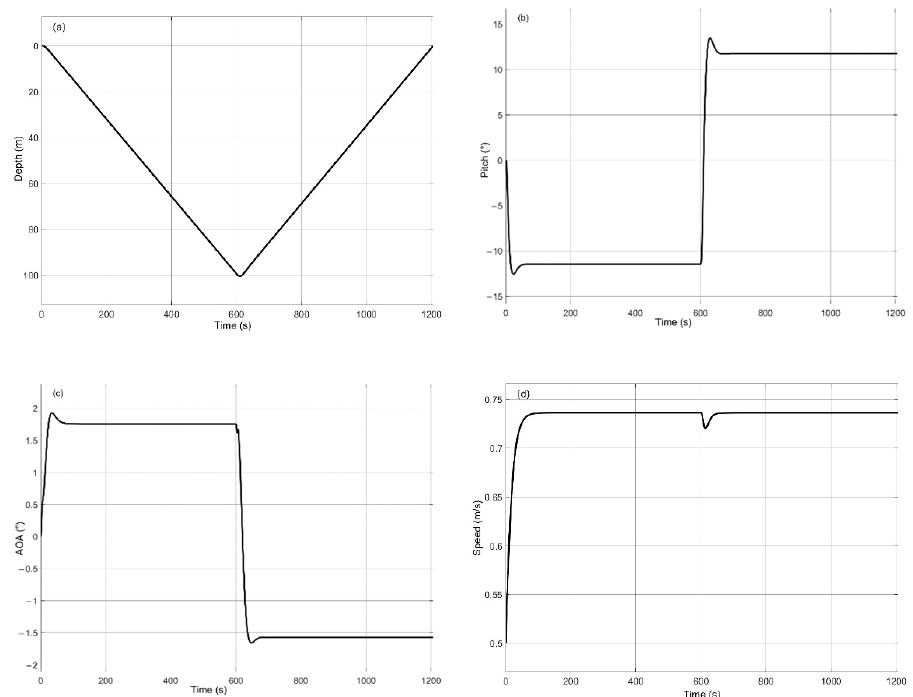
Figure 11. When 𝐹 (cid:3021) = 6N, ∆𝐵 = 1N, θ = 12° are set in yo-yo profile, the simulation results: ( a ) Figure 11. When F T = 6 N, ∆ B = 1 N, θ = 12 ◦ are set in yo-yo profile, the simulation results: ( a ) depth depth vs. time; ( b ) pitch vs. time; ( c ) AOA vs. time; ( d ) speed vs. time. vs. time; ( b ) pitch vs. time; ( c ) AOA vs. time; ( d ) speed vs. time.